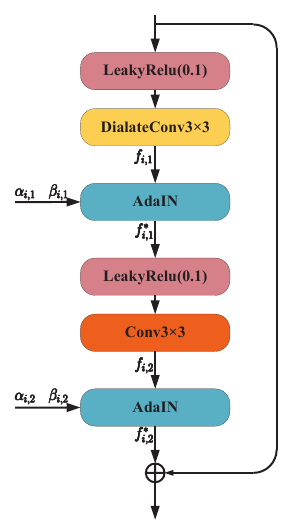
Figure 3. The style rendering